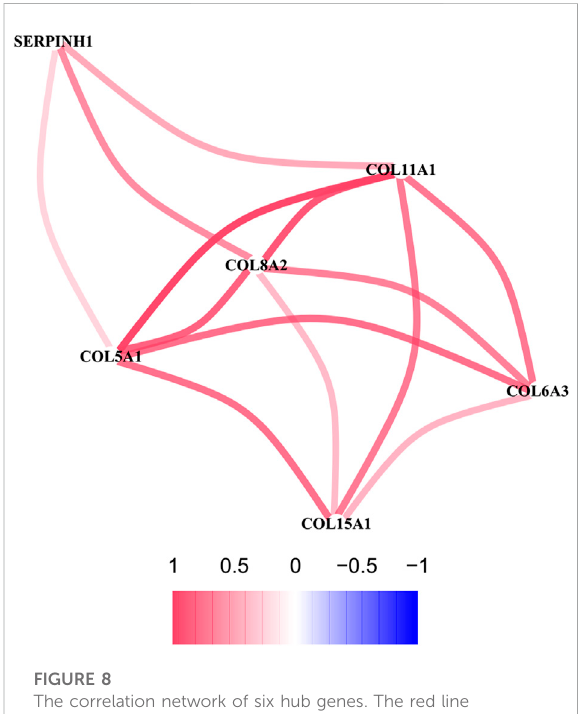
FIGURE 8 The correlation network of six hub genes. The red line represents a positive correlation between two genes, and the blue represents a negative